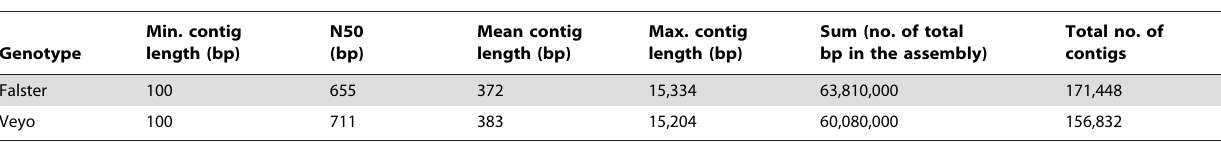
Table 2. Trasncriptome assembly results.